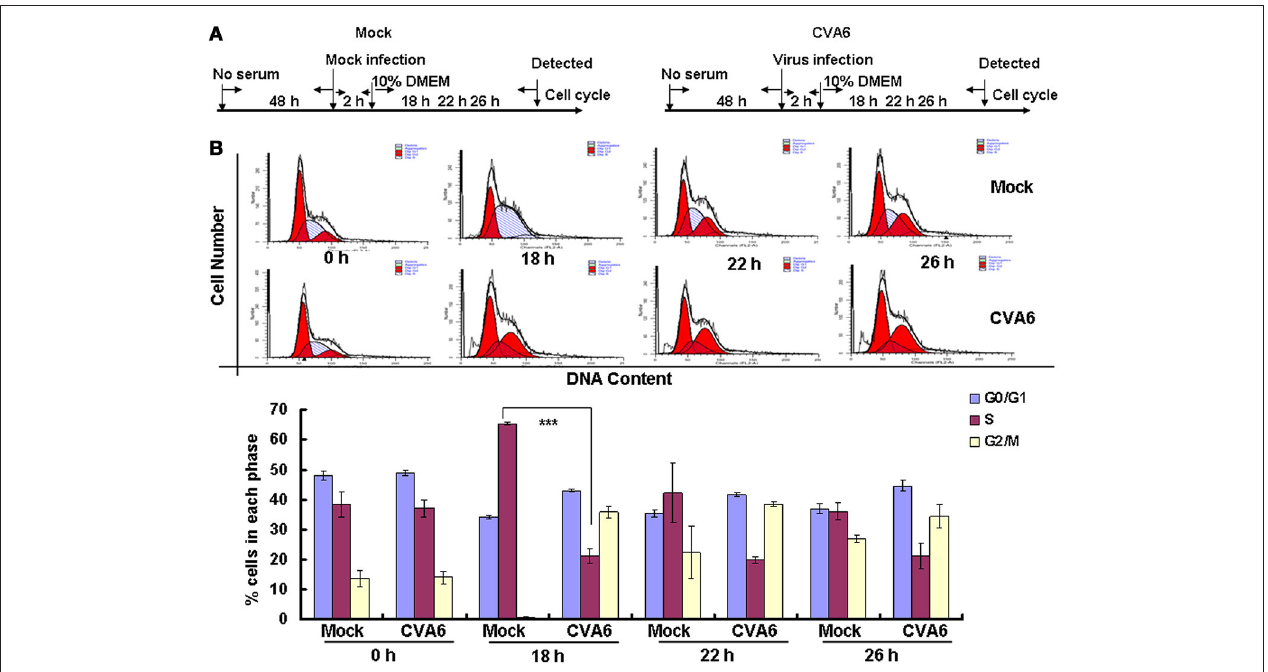
FIGURE 6 | CVA6 infection prevents cell exit from G0/G1 into S phase. (A) RD cells were cultured in serum-free medium for 48h and then mock-infected (Mock) or infected with CVA6 (CVA6) at an MOI of 1. After 2h of virus absorption, the cells were treated with medium containing 10% FBS. (B) Top panel: Flow cytometry determined the cell cycle profiles at 0, 18, 22, and 26h post-infection. Bottom panel: The histograms indicating the cell cycle distribution were analyzed by the ModFit LT program. The results represent the mean ± SD of three independent experiments. *** P <